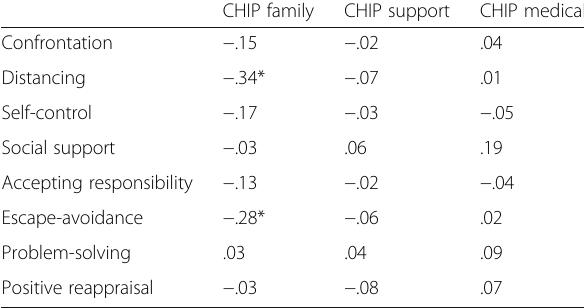
Table 4 Strength of the Spearman correlations between the dimensions of the CHIP and the Ways of Coping checklist CHIP